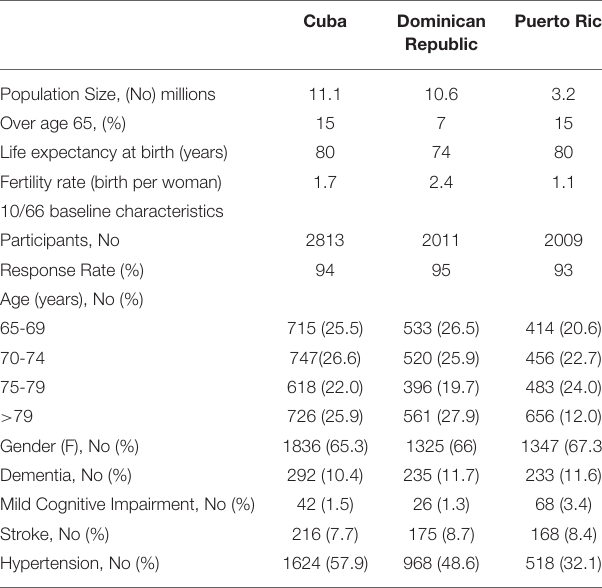
TABLE 1 | Caribbean Hispanics Islands population characteristics and 10/66 cohort profile.